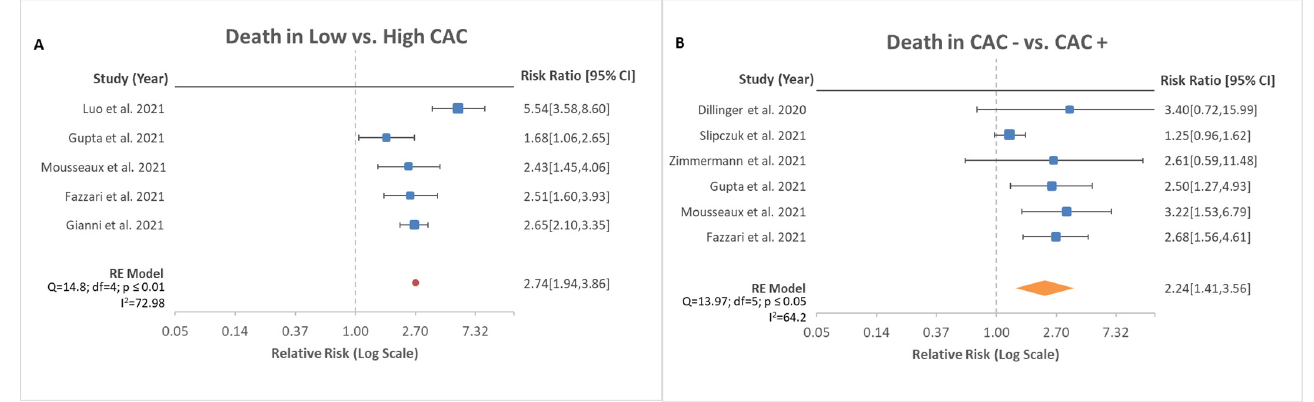
Figure 2. Risk ratio of death based on stratification of CAC scores. ( A ) depicts mortality in low CAC vs. high CAC with total of five studies analyzed with 95% confidence interval. Test for overall effect: Z = 5.71, p < 0.00001. ( B ) depicts mortality in absence of CAC vs. the presence of CAC with total of six studies analyzed with 95% confidence interval. Test for overall effect: Z = 3.40, p < 0.001.